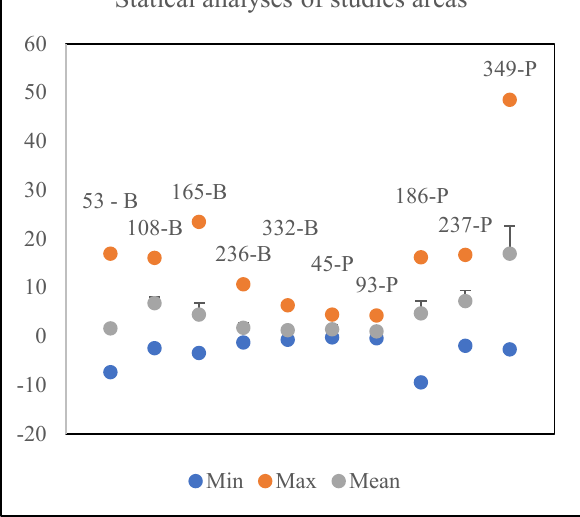
Figure 6. Statistical analyses of the images studied for each Day ff the Year (DOY). Where "P" is Pampa Biome and "B" is